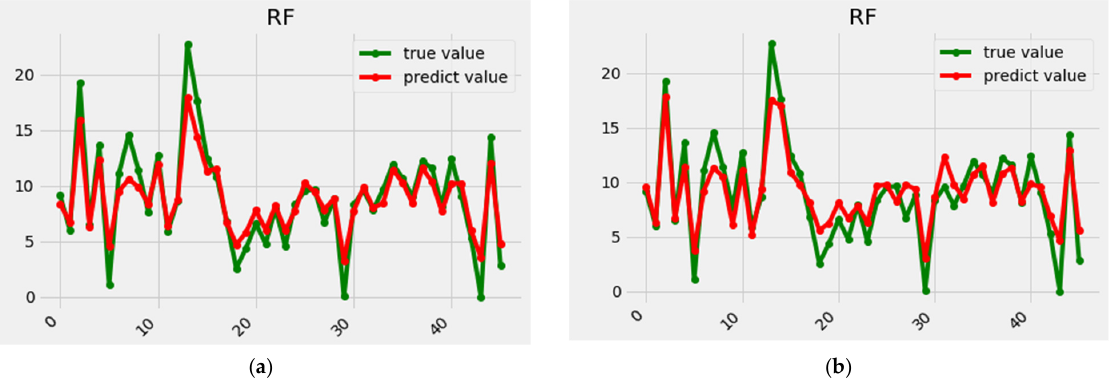
Figure 10. Fitted results of two InSAR methods with random forest. The left ( a ) represents a comparison between interference difference tree heights fitted using random forest and the right ( b ) represents a comparison of coherent amplitude tree heights fitted using random forest.